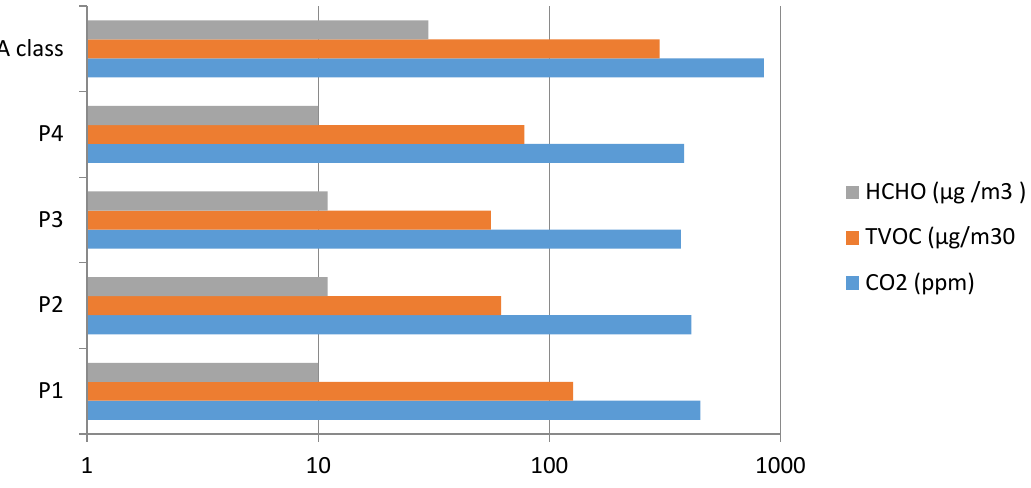
Figure 7. Results of pollutant concentration levels at P1–P4 measurement points and recommended values A class for HCHO, CO 2 and TVOC concentrations. Table 9. The IEQ sub-component models, the indoor parameters (input values) and IEQ index results for building (P avg ) assuming the realistic uncertainty.